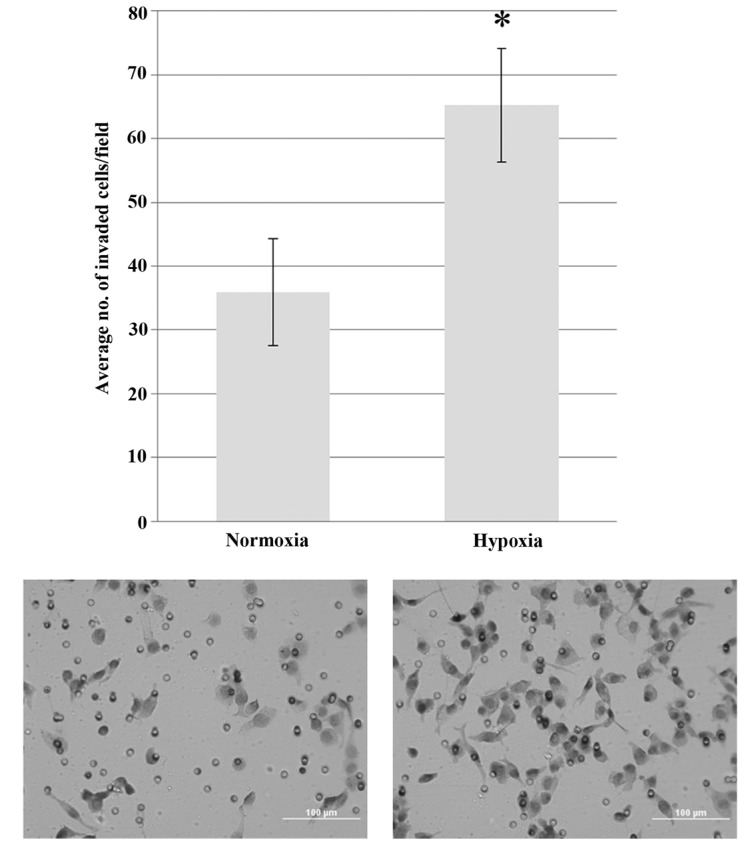
RMCCA-1 cell invasion in vitro after 24 h. The upper panel shows the average number of invaded cells per field, comparing between cells cultured under normoxic and hypoxic conditions. Values are expressed as the mean ± standard deviation (n=3). *P<0.05 vs. normoxia. The lower panel shows representative images of the invasion assay (scale bar, 100 µm).